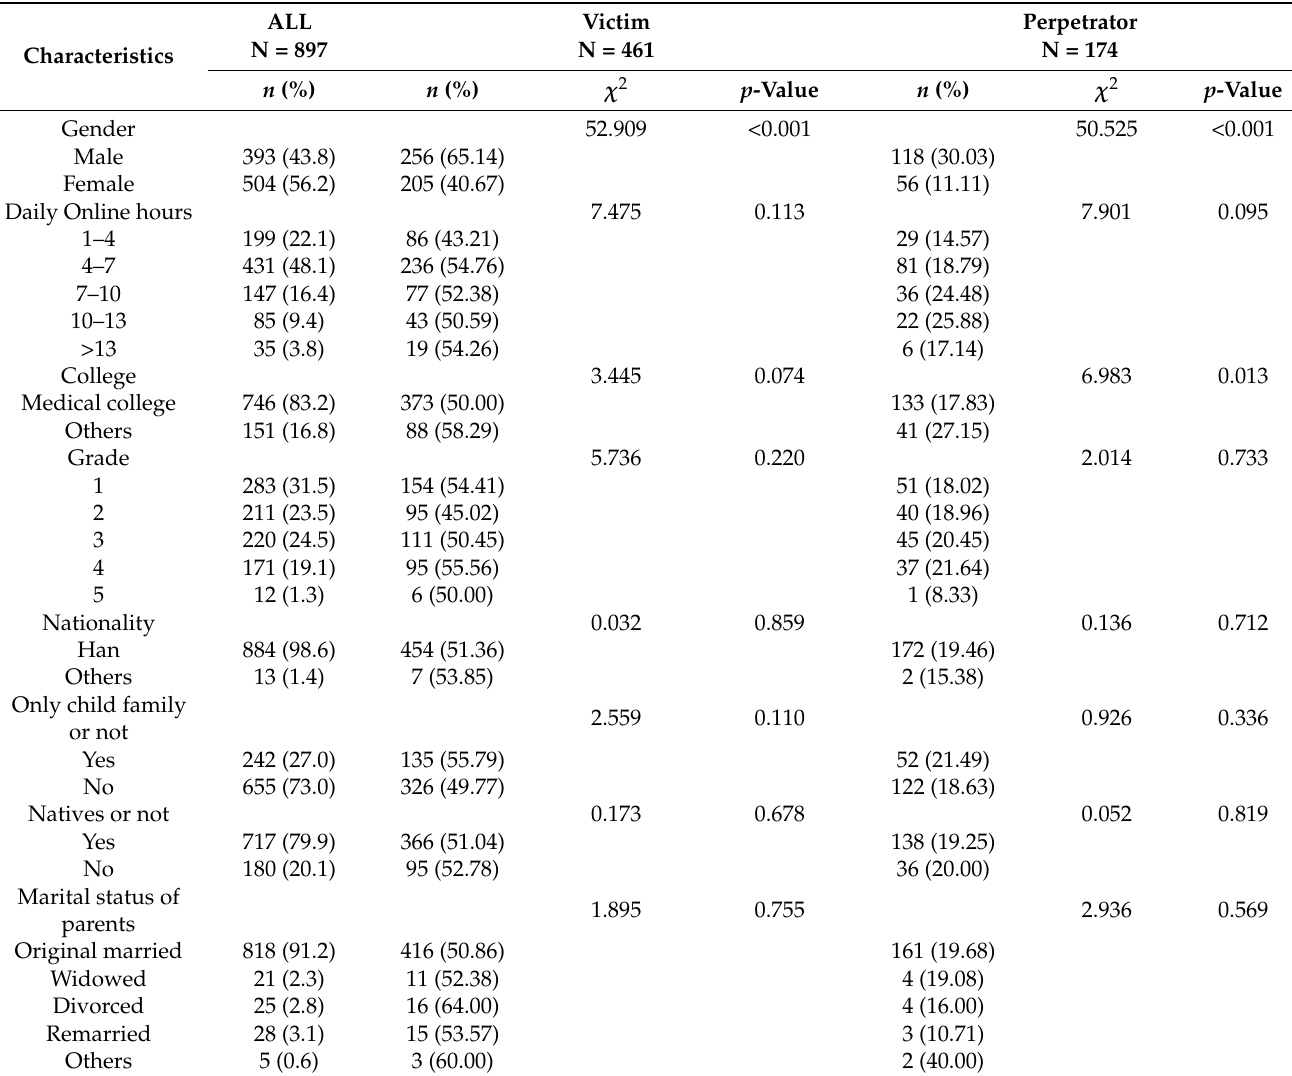
Table 1. Univariate analysis of cyberbullying in social media among college students.